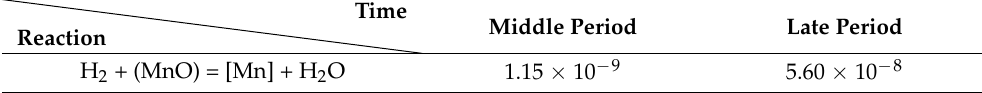
Table 12. Equilibrium ratios of water and hydrogen for reaction H 2 + (MnO) = [Mn] + H 2 O.